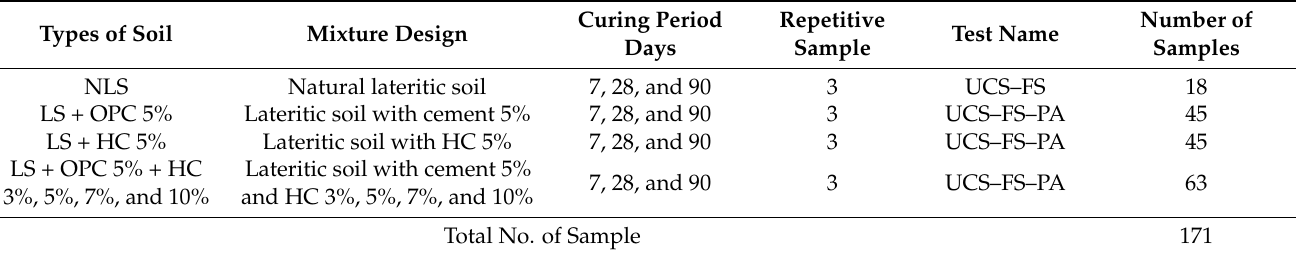
Table 2. Designation mix used in this